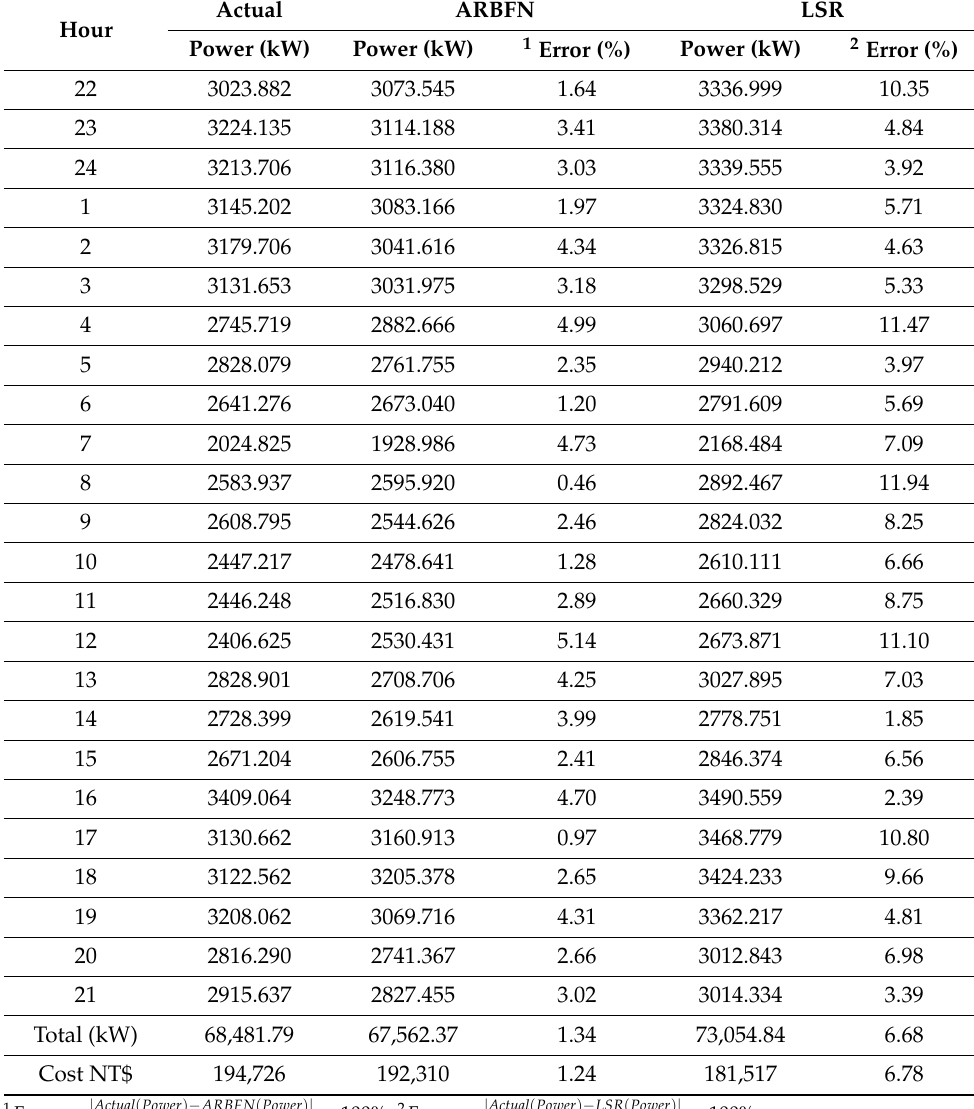
Table 3. Comparative analysis of power consumption on a summer